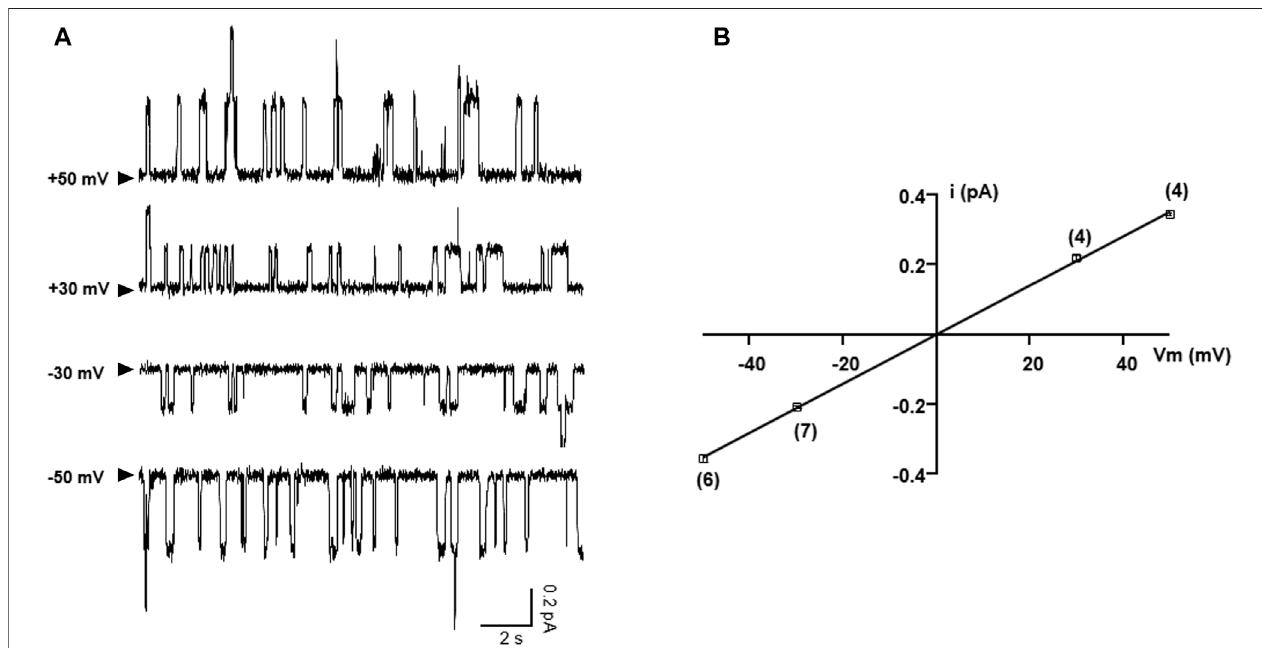
FIGURE 8 | Single-channel I-V relationship of G542X-CFTR treated with DMSO. (A) Representative single-channel current traces of G542X-CFTR at different holding potentials. The arrowheads indicated that the baseline (closed state). (B) Single-channel I-V plot of G542X-CFTR, where the horizontal axis is the membrane potential(Vm),andtheverticalaxisisthesingle-channelamplitude(I).Thesquaresaremeansingle-channelcurrentamplitudeswiththeerrorbarsrepresentingSEMand thenumbersofobservationsareindicatedinthesquares.Theblacklinerepresentsalinear fi tofthesingle-channel I-V relationshipofG542X-CFTR,yieldingasingle channel conductance of 6.75 pS, which is similar to that of WT-CFTR (Yeh et al., 2015).